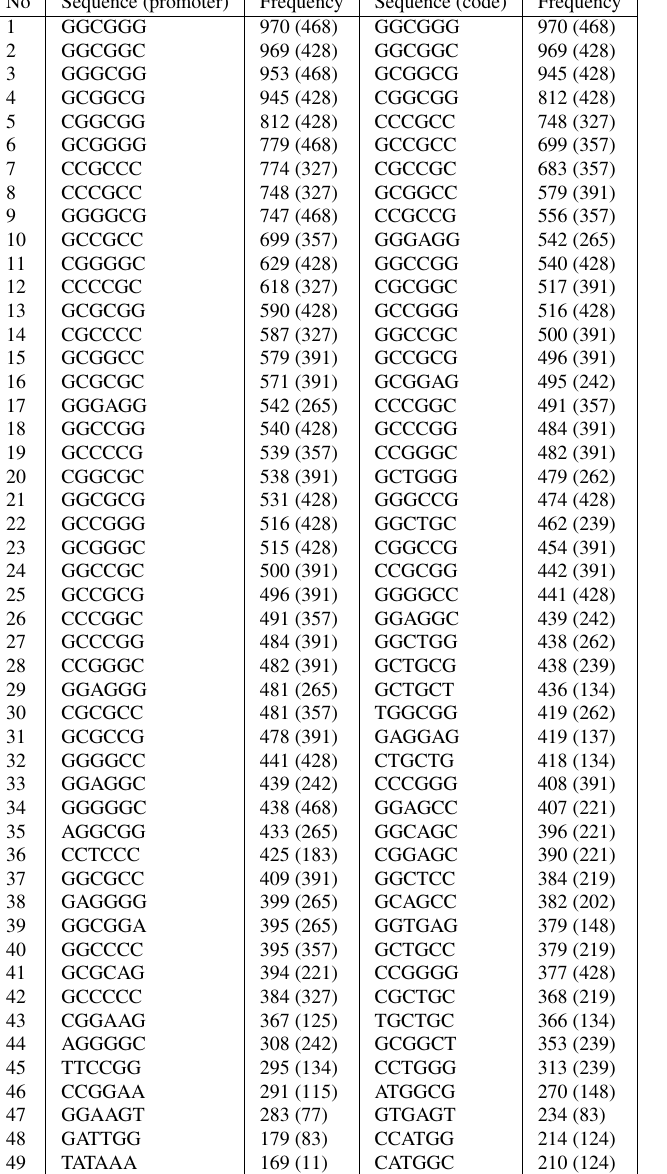
Table 1: The distribution of the most common 49 hexanucleotide sequences around the transcrip- tion start site (the reported frequencies cover the entire range –100 to + 100). The numbers in parenthesis are the expected frequencies computed